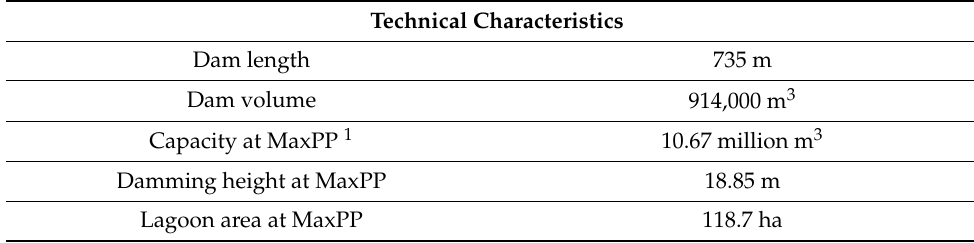
Table 1. Basic parameters of Szalej ó w G ó rny